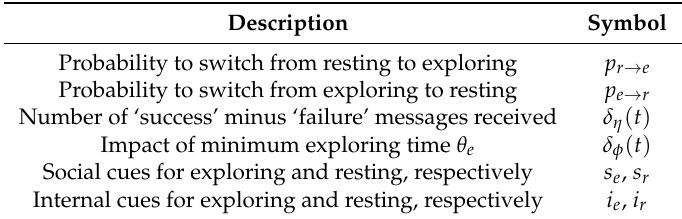
Table 1. An overview of parameters defining the switching